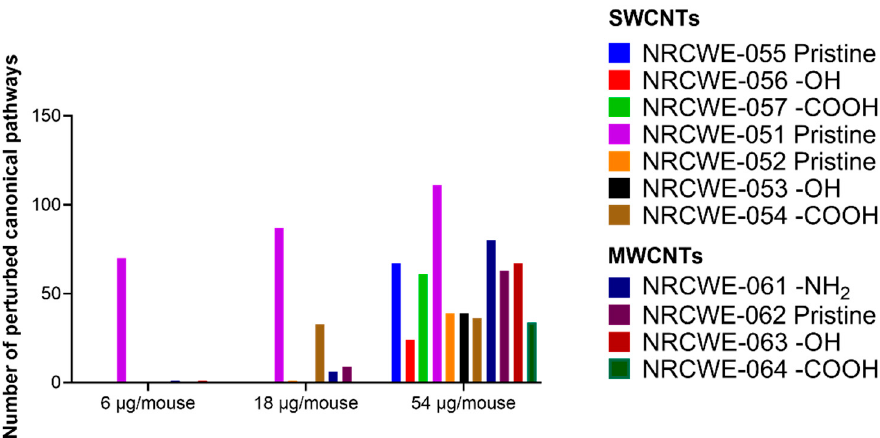
Figure 4. Number of significantly perturbed canonical pathways after exposure to individual SWCNTs or MWCNTs in each dose after 1 day of exposure. The graph represents the number of canonical pathways consisting of at least five DEGs and exhibiting a − log ( p -value) ≥ 1.3.